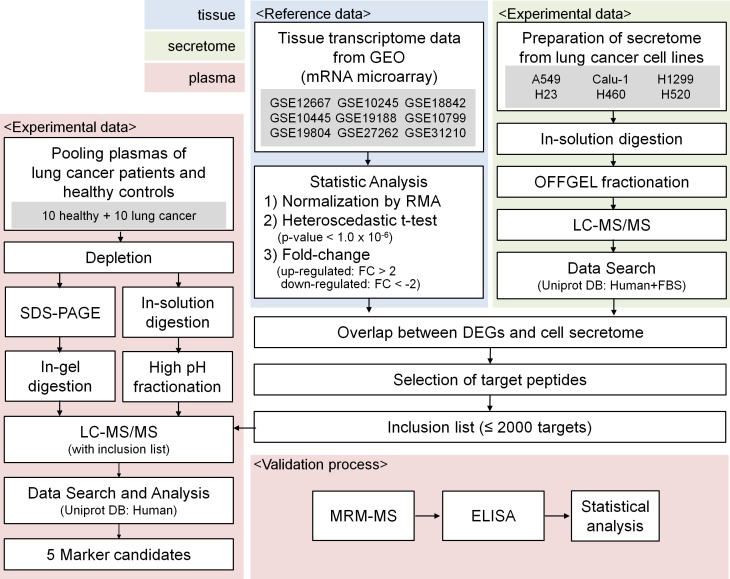
Schematic workflow.